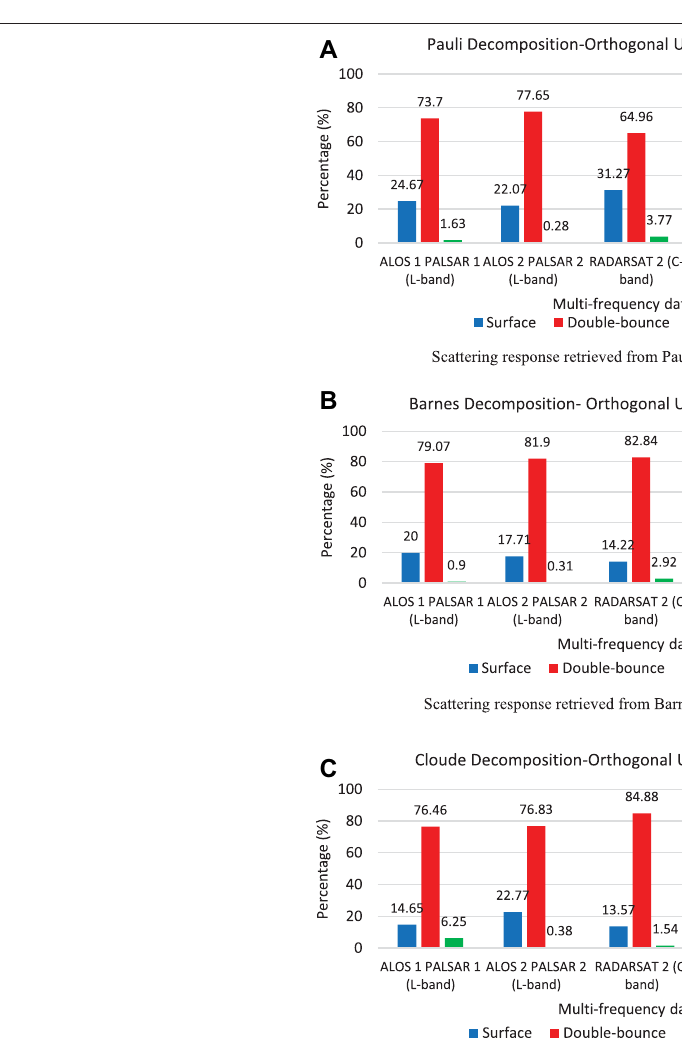
Frontiers in Earth Science |